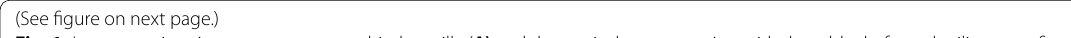
figure on next Fig. 1 Intraoperative view on a severe atrophied maxilla ( A) and the vertical augmentation with three blocks from the iliac crest, fixed with two screws each ( B ). The BMCA was mixed with autogenous bone chips and DBBM ( C) to cover and contour the augmentation ( D ). The augmentation was covered with resorbable membranes followed by tension-free wound closure ( E , F ). Six months after the augmentation four implants were inserted ( G , H